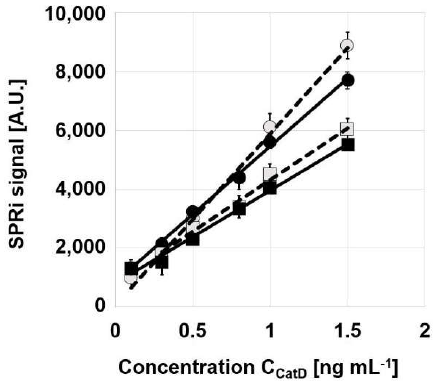
Table 2. Parameters of linear sections of calibration curves of Cath D determination.